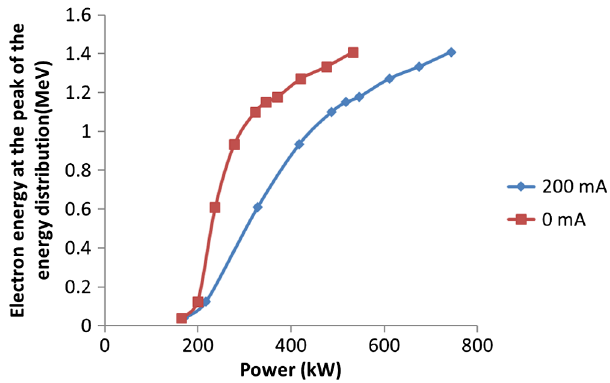
FIG. 12. Peak energy as a function of power using shunt impedance and beam loading.